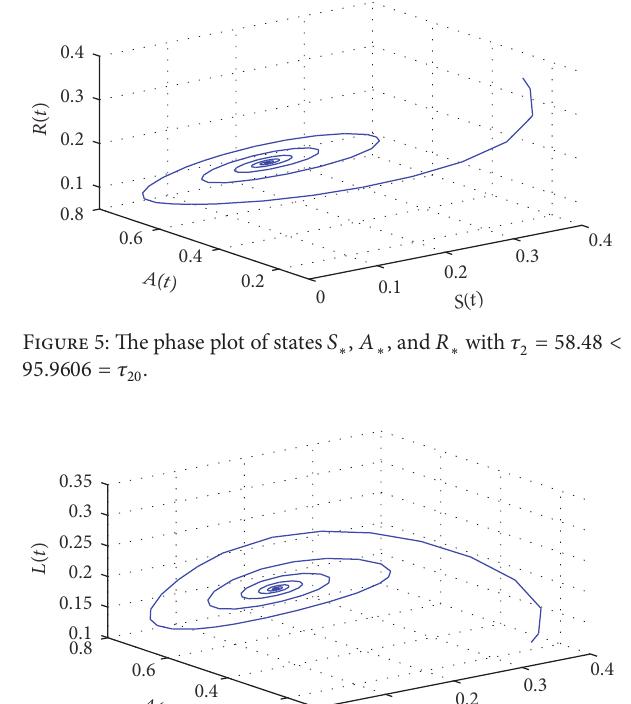
Figure 2: The phase plot of states 𝑆 ∗ , 𝐿 ∗ , and 𝐴 ∗ with 𝜏 1 = 22.36 < 28.4522 = 𝜏 10 .